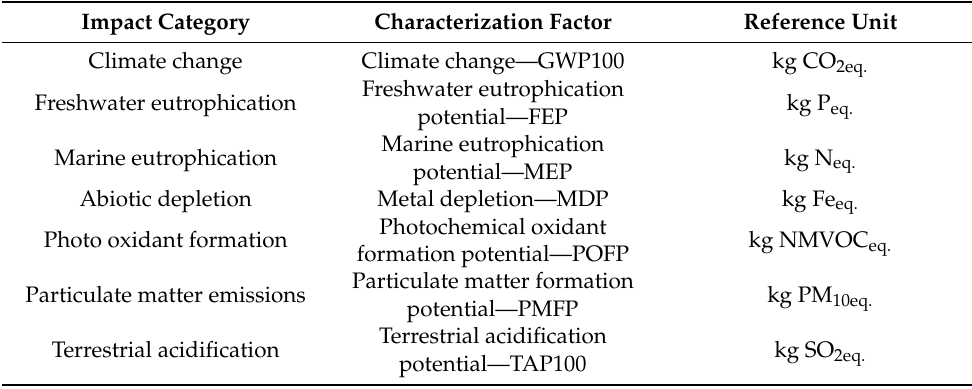
Table 2. Impact categories included in the